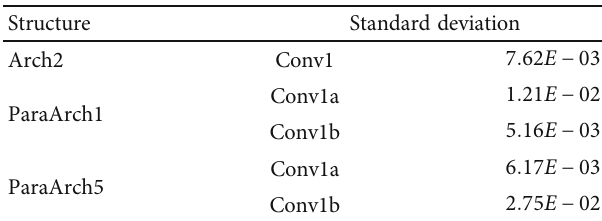
Figure 7: Variation curve of the NP-DP-DCNN parallel DCNN classi fi cation error rate and number of iterations. Table 2: Comparison of standard deviation of the fi rst convolution layer in Arch2, ParaArch1, and ParaArch5